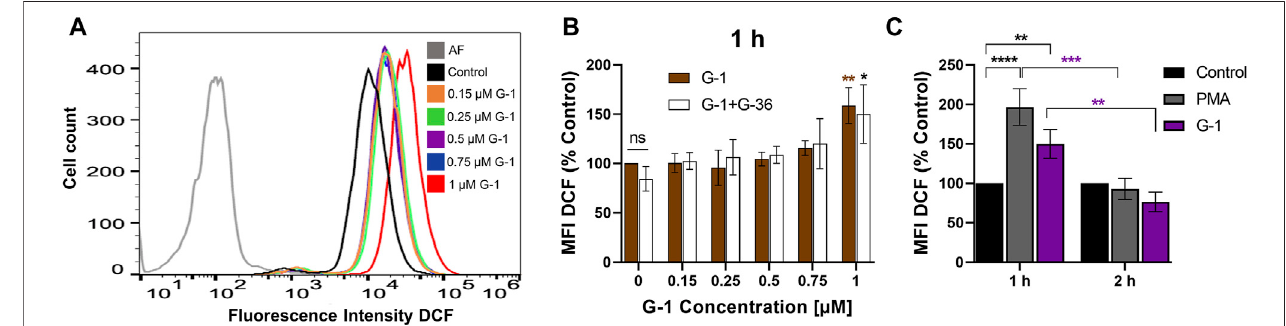
FIGURE 4 | G-1 induces ROS production in Jurkat cells. Cells were treated as indicated during 1 or 2 h and stained with the indicator of ROS activity DCF-DA (5 μ M, 30 min). DCF fl uorescence was collected by fl ow cytometry, and mean fl uorescence intensity (MFI) was determined. (A) Representative histogram obtained with G-1 – treated cells. Theauto fl uorescent population (AF)isshown ingray. (B) Jurkat cellswere pre-incubatedwithG-36 (10 μ M, 30 min),or not, and treated withgrowing concentrations of G-1 for 1 h. MFI values of treated cells were normalized to control (untreated cells) and shown as mean ± SEM. Comparison of the mean of treatedsamplestountreated controlwasperformed usingtwo-wayANOVA andaDunnett post hoc test, * p < 0.05,** p < 0.01. Comparison ofG-36 pre-incubatedwith the corresponding not pre-incubated samples was also performed for each G-1 concentration, using two-way ANOVA and Sidak post hoc testing; no statistical signi fi cance wasfound. (C) MFI DCF values wereobtained after 1 and 2 h ofincubation withG-1(1 µM) or PMA(5 µM) asapositivecontrol and normalizedto untreated control. Data are mean ± SEM, N ≥ 3. Statistical analysiswas performed bycomparing the mean oftreated and control samplesusing two-way ANOVA and Tukey